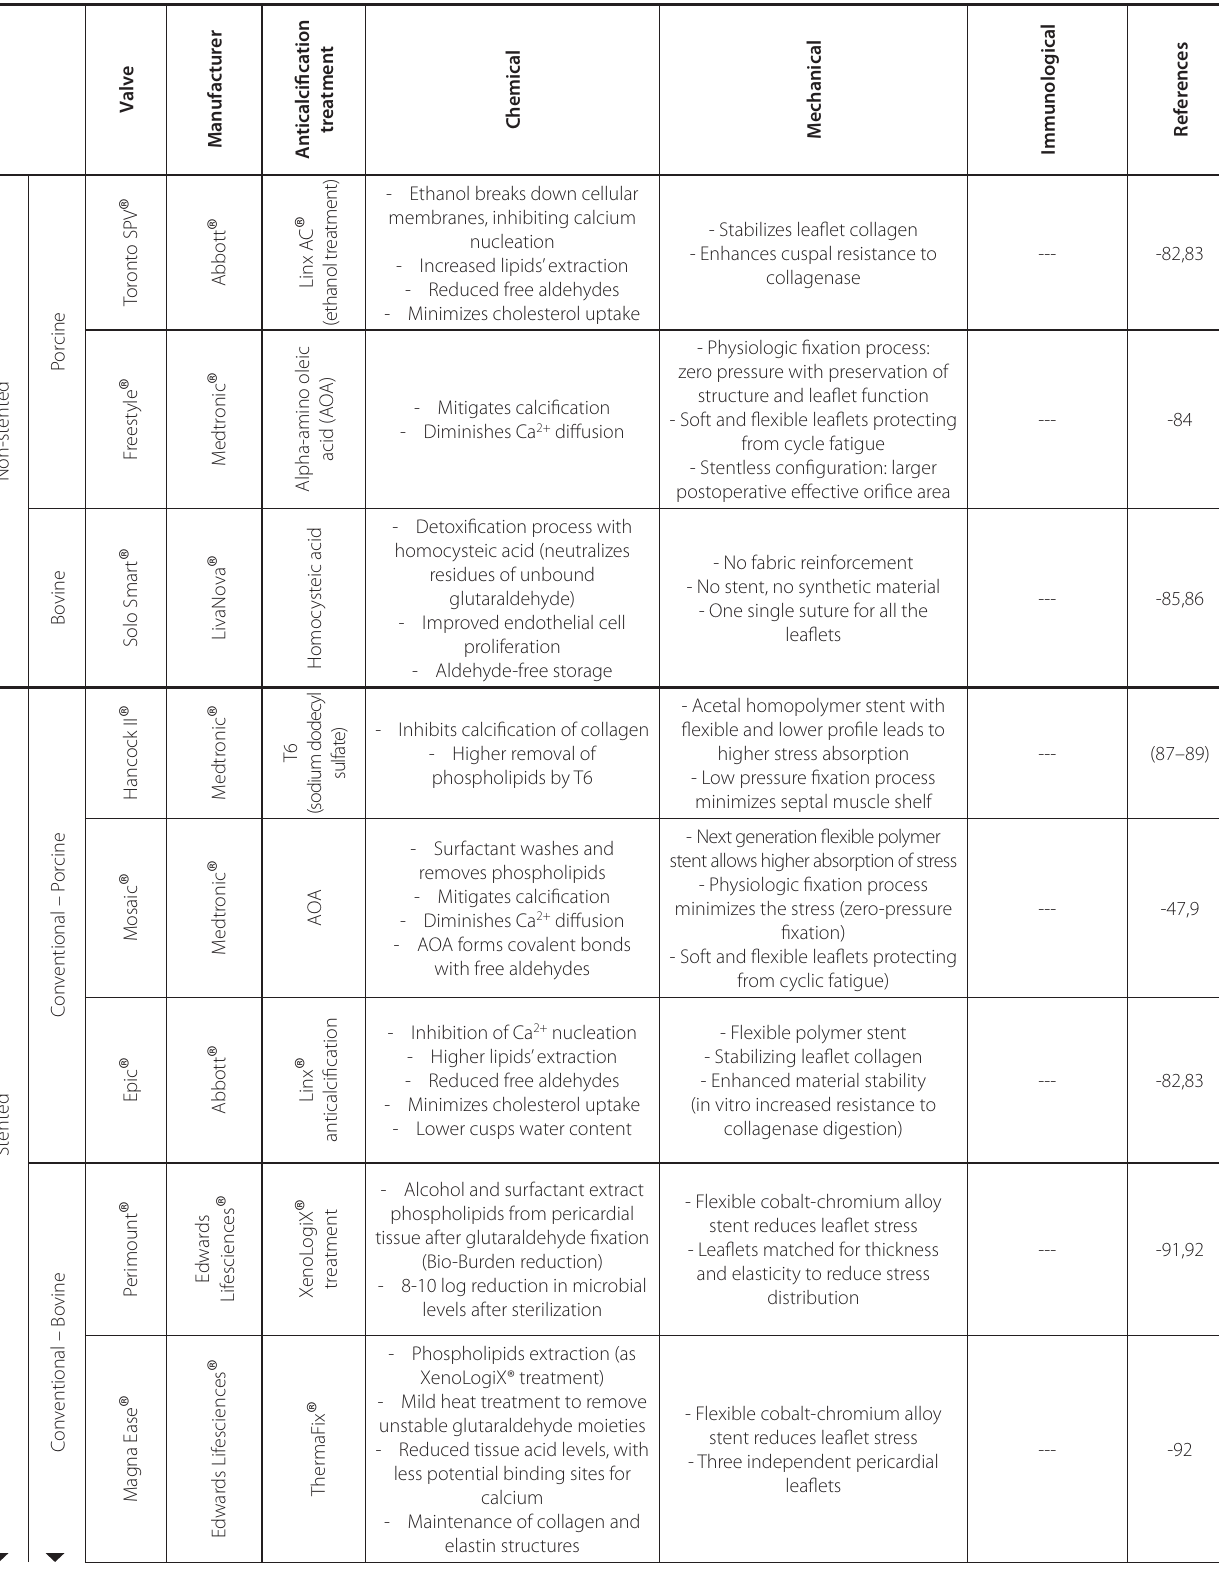
Table 1 . Comparison of chemical, mechanical, and immunological advances between bioprosthetic valves.